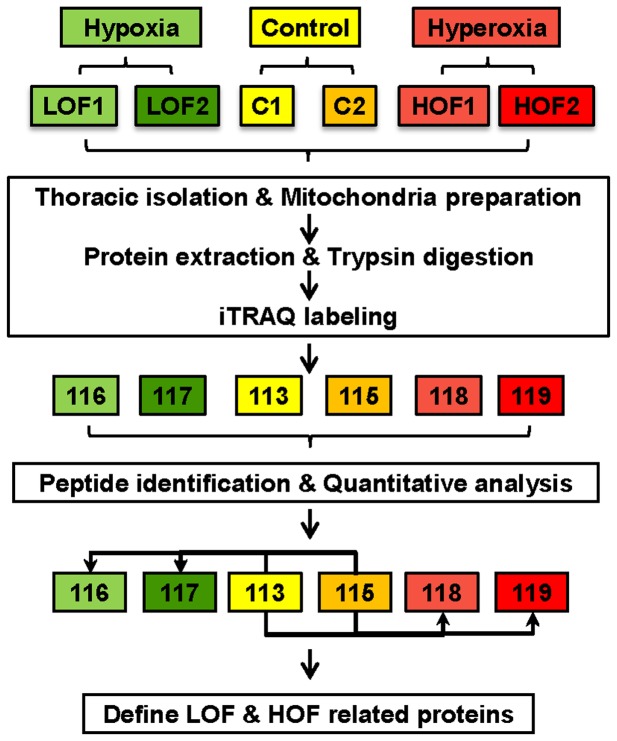
Schematic illustration of the experimental workflow and overview of the proteomic experiments.To characterize the mitochondrial proteomes of control (C), hypoxia-adapted flies (LOF), and hyperoxia-adapted flies (HOF), a MS-based experiment was performed. Thoracic muscle mitochondrial samples were isolated from control, LOF, and HOF. Proteins were extracted and digested with trypsin. Peptides were labeled using iTRAQ tags, equally mixed, and then pre-fractionated using strong cation exchange (SCX). Two biological replicates were performed for each experiment. SCX fractions were analyzed by high-resolution LC-MS/MS. Differentially expressed proteins were identified by comparing LOF and C (for differentially expressed proteins in LOF) or HOF and C (for differentially expressed proteins in HOF).